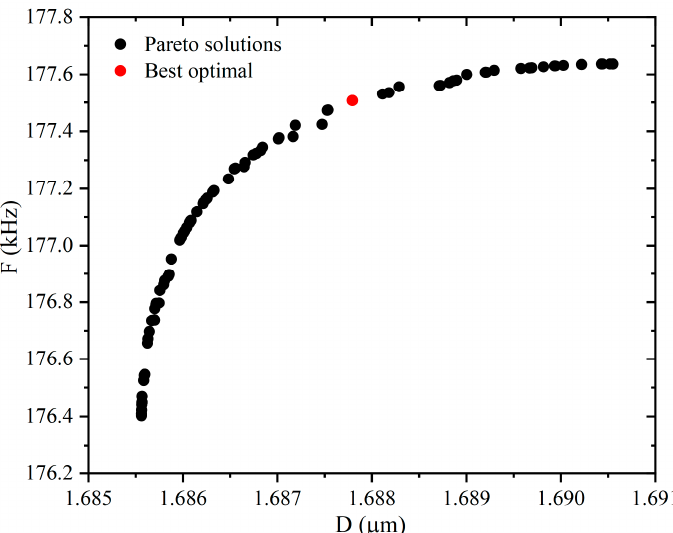
Figure 8. Pareto optimal front. Table 3. Comparison between numerical and RBF predicted values.